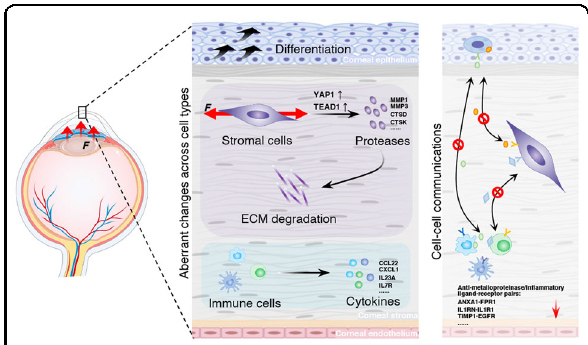
Fig. 7 Model of keratoconus-related changes across cell types in the central cornea. In the cornea in fl icted with keratoconus, mechanical stretch promotes the expression of several protease genes in stromal cells and aggravates ECM degradation, and the abnormal differentiation of corneal epithelial cells and elevated in fl ammatory signals were also detected (middle panel). Moreover, the dysregulated cell – cell communications occur in keratoconus corneas, especially for ligand-receptor pairs related to protease inhibiting and anti- in fl ammatory processes (right panel). The mechanical stretch exerted on cells was indicated by red